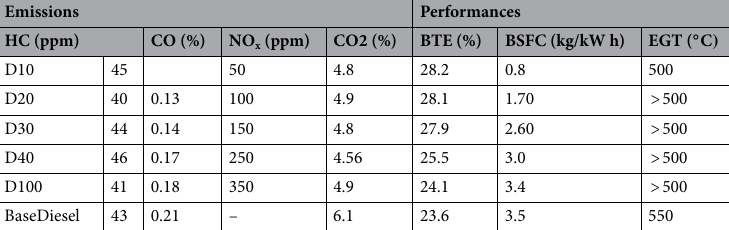
Table 2. Comparison of the present